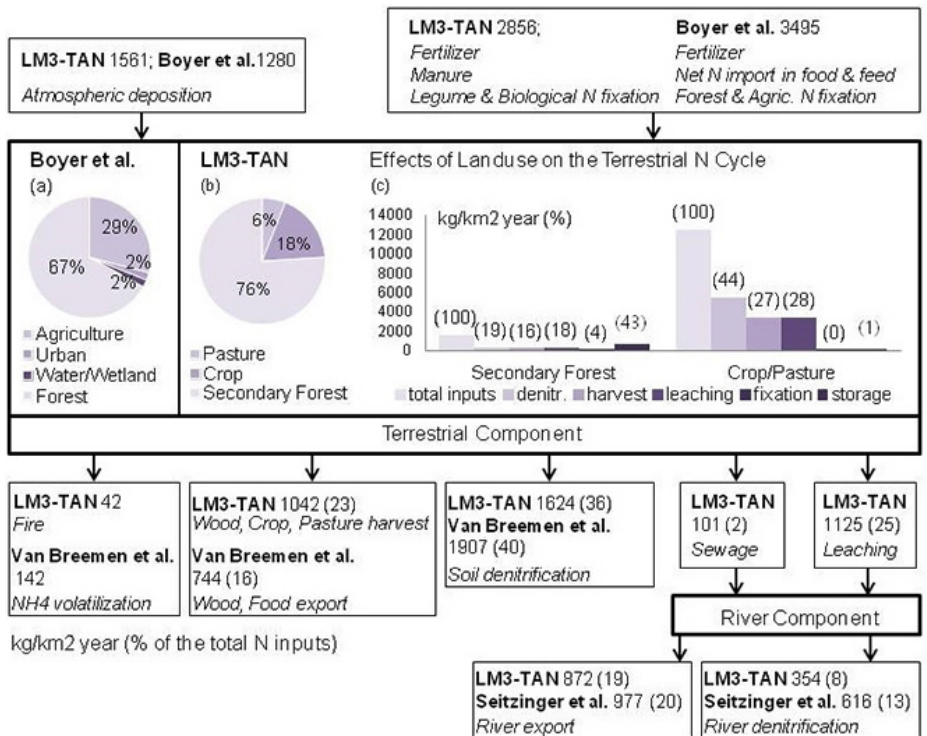
Figure 9. Comparison between the calculated and reported budgets of N sources, retention, lost, transport, and river export at the level of the whole Susquehanna watershed for the period 1988–1992 (Boyer et al., 2002; Breemen et al., 2002; Seitzinger et al., 2002; USEPA, 2010a).